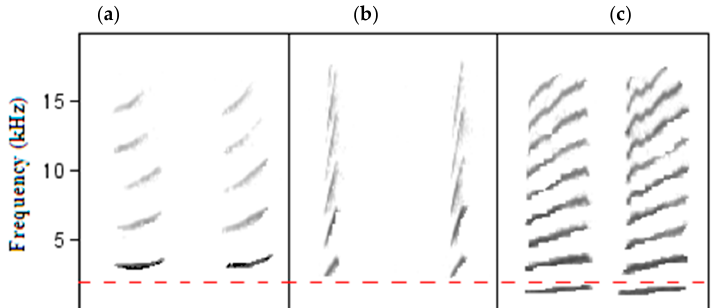
Figure 3. Spectrograms of three of the Noisy miner calls. ( a ) Adult aerial alarm call (AC1) and ( b ) juvenile begging call (BC) ‘naturally’ avoid low-level anthropogenic noise (1–2 kHz, marked by broken red line). ( c ) The lower frequency adult chur alarm call (AC2) does not avoid masking and showed a small shift in minimum frequency in urban birds.